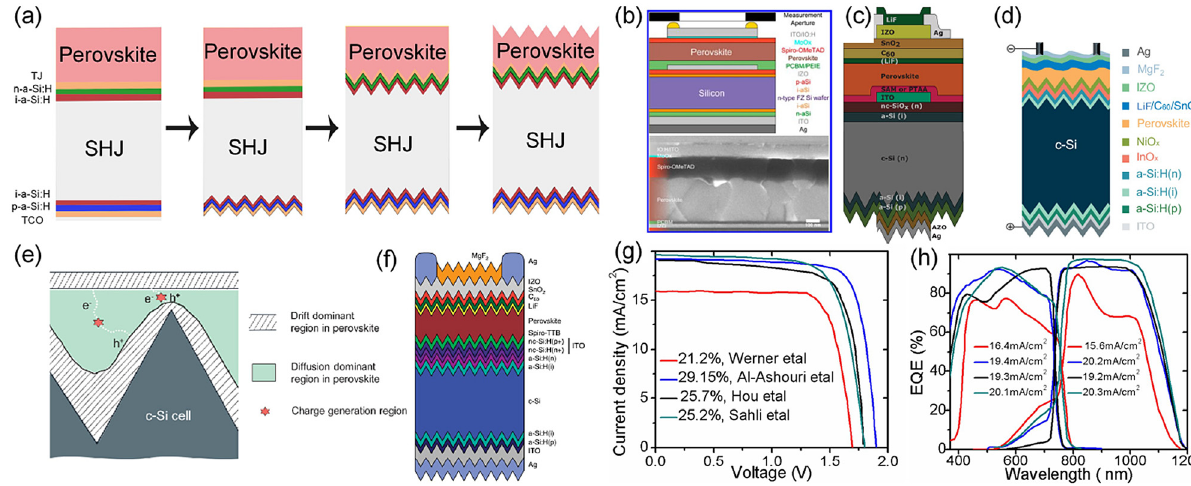
Figure 4: (a) Structure evolution of perovskite/SHJ tandem devices. (b) Cell design of perovskite/ SHJ TSCs with a double side planar SHJ bottomcell[67].Copyright2018,AmericanChemicalSociety.(c)Schematicviewofperovskite/SHJTSCswithafrontplanarSHJbottomcell[52]. Copyright 2020, The American Association for the Advancement of Science.(d) Schematicdrawingof perovskite/SHJ TSCs with a textured SHJ bottom cell. Solution-processed micrometer-thick perovskite layer fi lls the bottom of the pyramid [56]. Copyright 2020, The American Association for the Advancement of Science. (e) Schematic view of electric- fi eld distribution in textured tandem device [56]. Copyright 2020, The American Association for the Advancement of Science.(f) Schematicdevicedesign of perovskite/SHJ TSCs with a texturedSHJ bottom cell [60]. Conformal perovskite layer is deposited on textured SHJ bottom cell. Copyright 2018, Springer Nature. (g) EQE spectra of perovskite/SHJ tandem cells with different SHJ bottom cells [52, 56, 60, 67]. (h) J – V curves of tandem devices with different SHJ bottom cells [52, 56, 60,